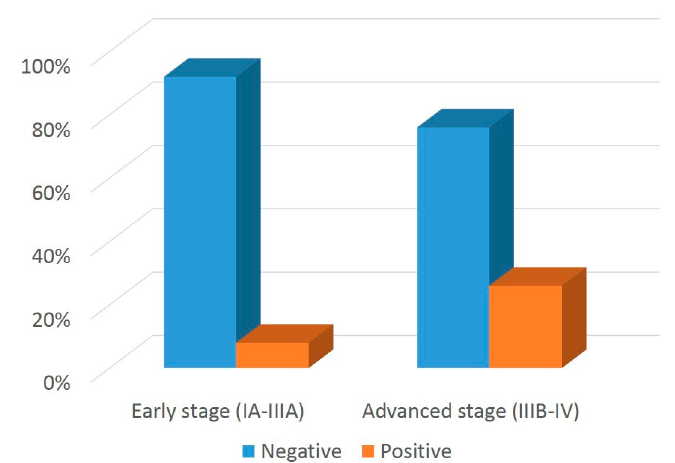
Figure 2. CNV (copy number variation) distribution in early- and advanced-stage tumors. Bar graphs show the percentage of samples that scored positive or negative for CNV detection.